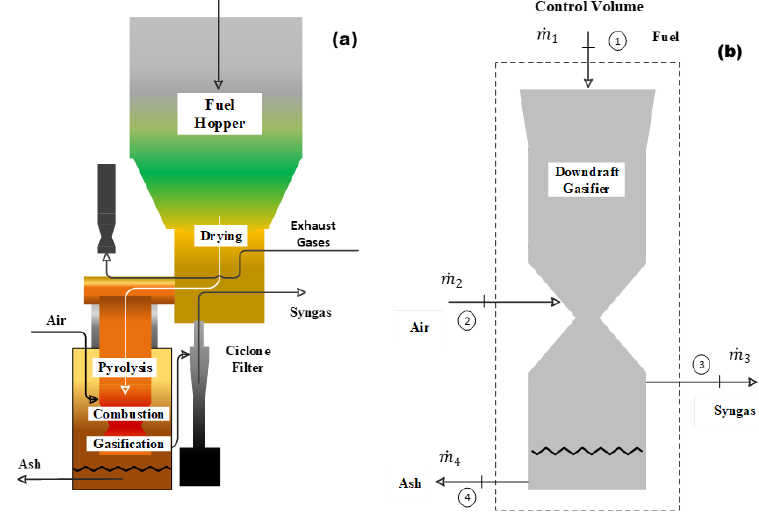
Figure 1. ( a ) Physical diagram of the system, and ( b ) control volume of the downdraft